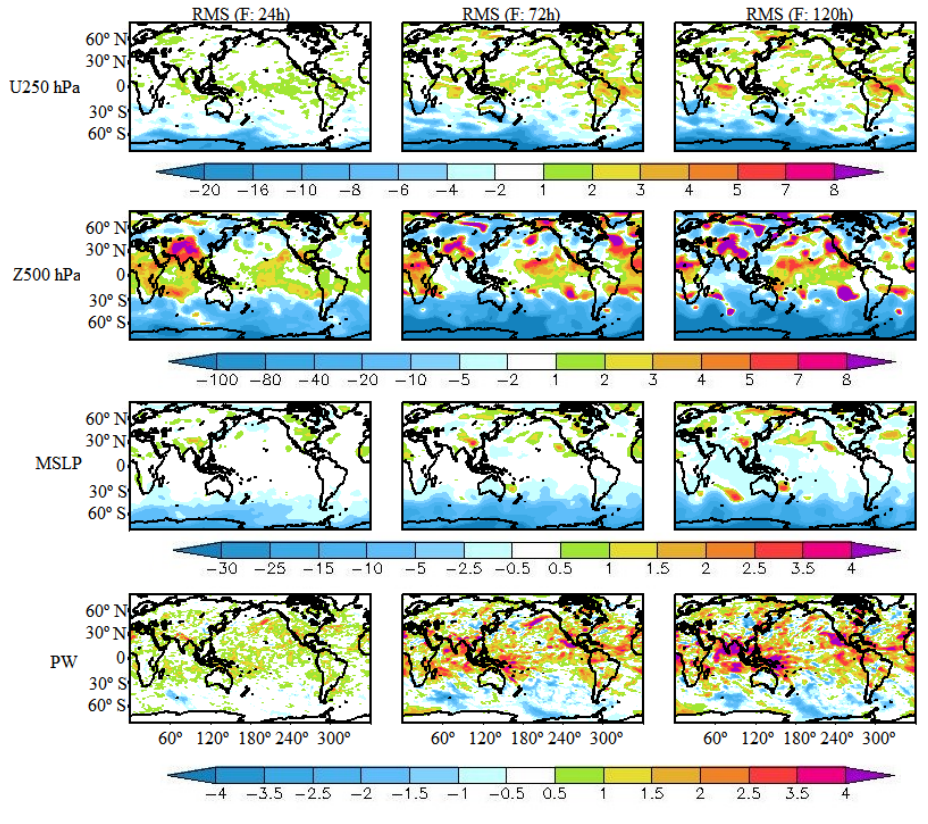
Figure 3. Differences in the root mean square (RMS) between PRH and NRH experiments for 24, 72, and 120 h of forecast. Fields: zonal wind of 250 hPa (U250 hPa), geopotential heights of 500 hPa (Z500 hPa), mean sea level pressure (MSLP), and precipitable water